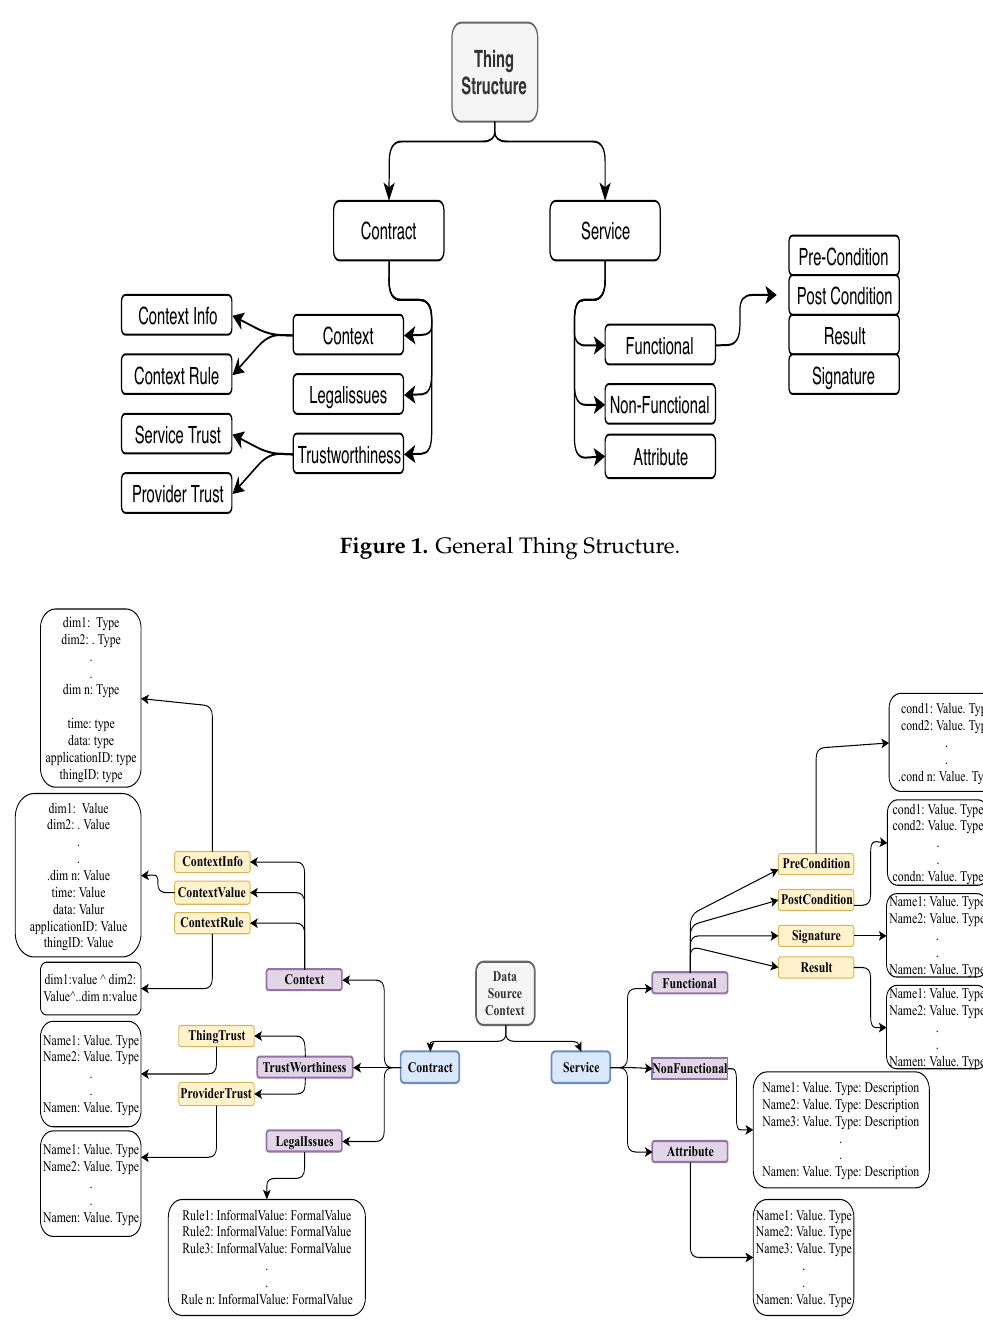
Figure 2. The Thing Implementation